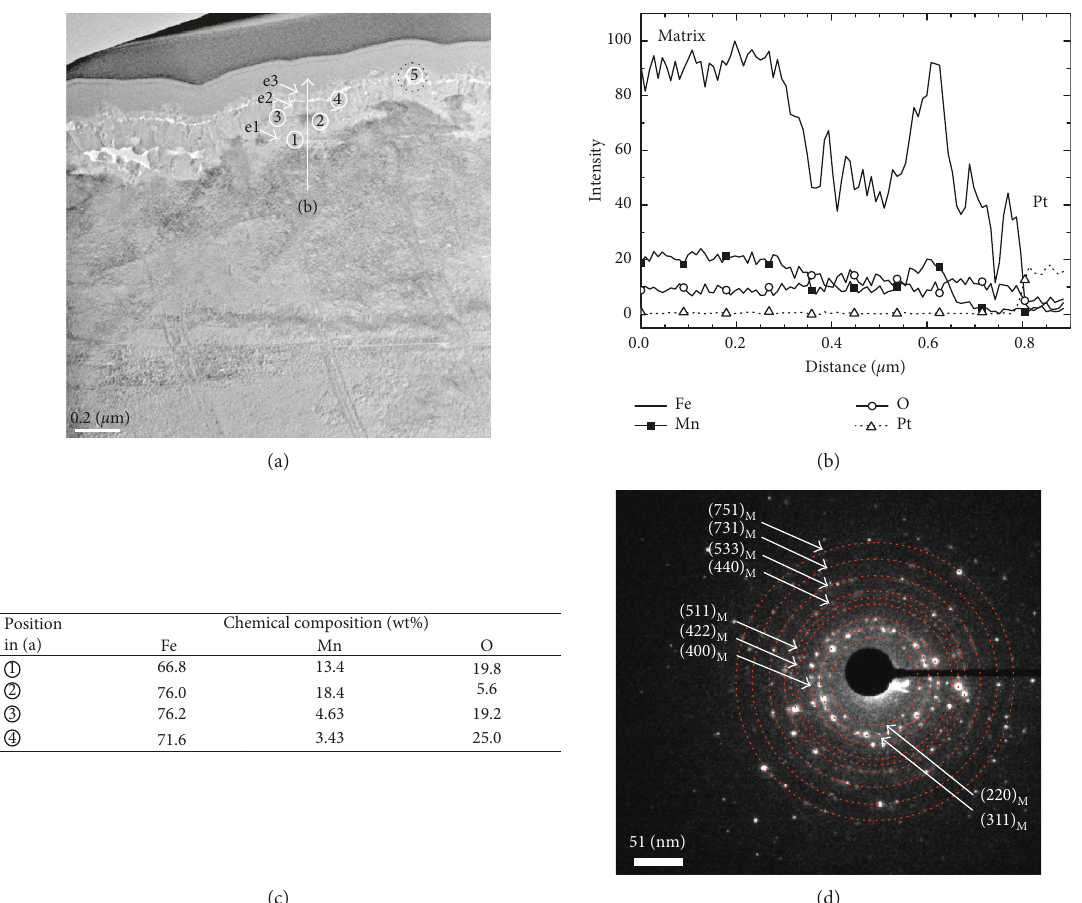
Figure 7: Cross-sectional TEM image (a), EDS line profile (b), EDS quantitative analysis of selected points 1, 2, 3, and 4 (c), and SAED (d) of region 5 in rust formed during 56-day immersion of 18Mn in 3.5% NaCl solution at 60 ° C, where subscript M indicates